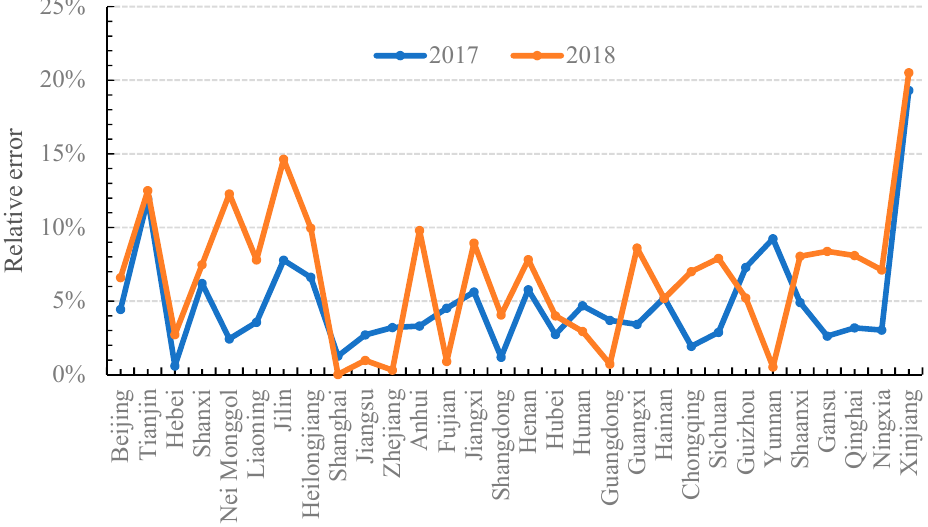
Figure 6. Relative errors of different provinces in 2017 and 2018.